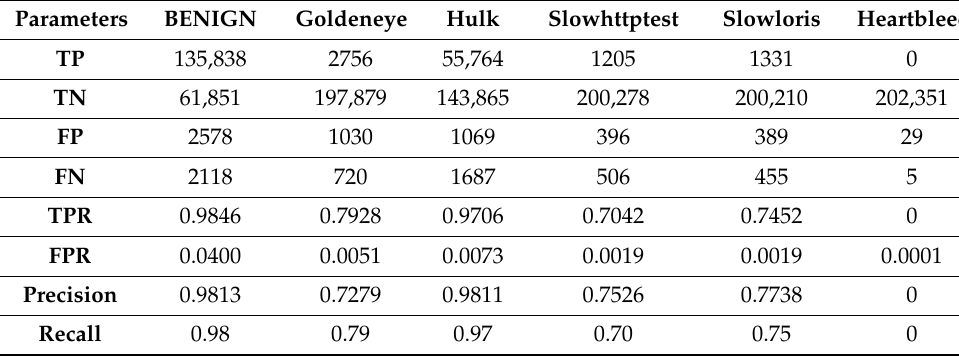
Figure 14. Friday afternoon PortScan confusion matrix. Table 5. Statistical report of Wednesday test dataset.